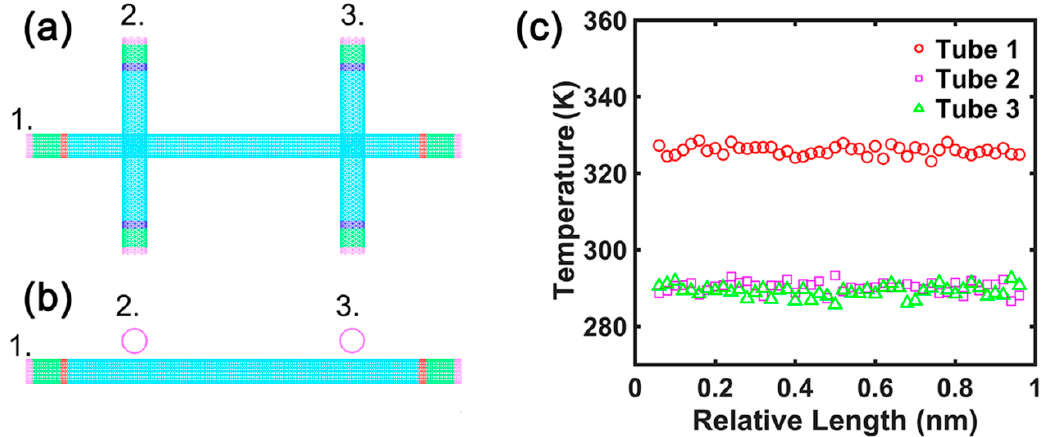
Figure 3. The calculation model 1 for the contact conductance of the double thermal contacts: ( a ) aerial view; ( b ) front view. ( c ) Typical temperature profile of the three carbon nanotubes in the double thermal contacts.